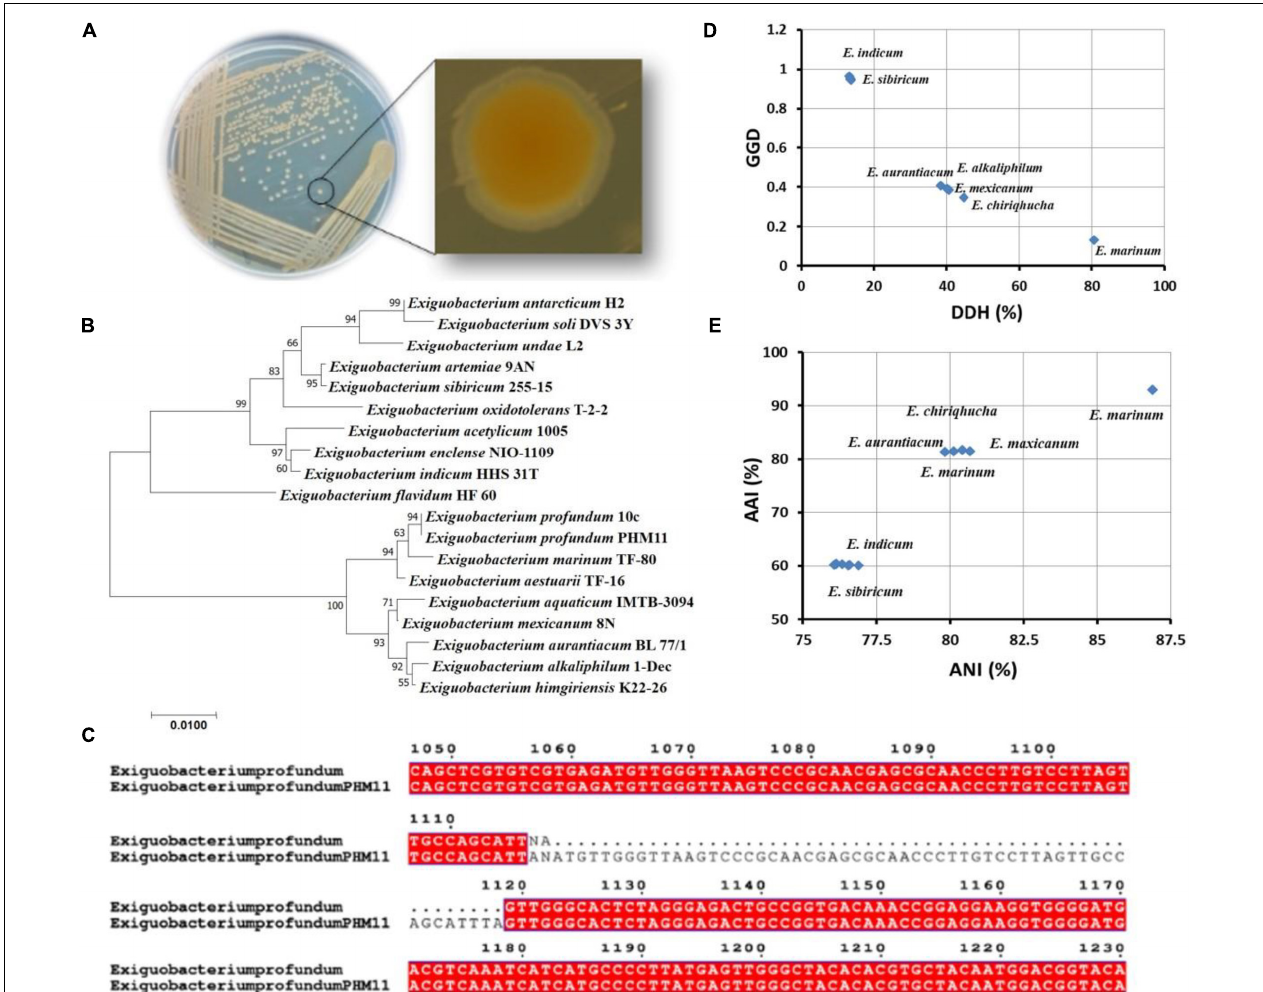
FIGURE 1 | Genome comparison of type strains of Exiguobacterium spp. (A) Colony shape and pigmentation of the strain. (B) Phylogenetic tree analysis of type strains of Exiguobacterium spp. using MEGA-X using the 16S rRNA sequence. The sequences were aligned by ClustalW, and the neighbor-joining method was used for the phylogenetic tree preparation. The stars represent branching of the strains in two major groups. (C) The pairwise sequence alignment of the 16S rRNA sequence of E. profundum type strain (10C) and the E. profundum PHM11. The alignment was done using ClustalW, then the alignment file was submitted to ESPript, and a final figure was generated. (D) Represents the graph between GGD and DDH of twelve type strains of Exiguobacterium species with reference to the E. profundum PHM11, and (E) represents AAI vs. ANI graph of 12 type strains of Exiguobacterium species with reference to the E. profundum PHM11.